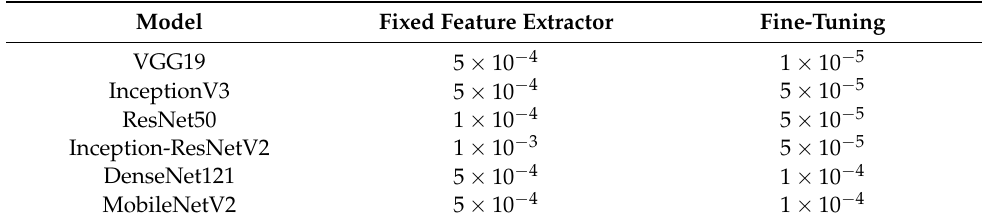
Table 3. Learning